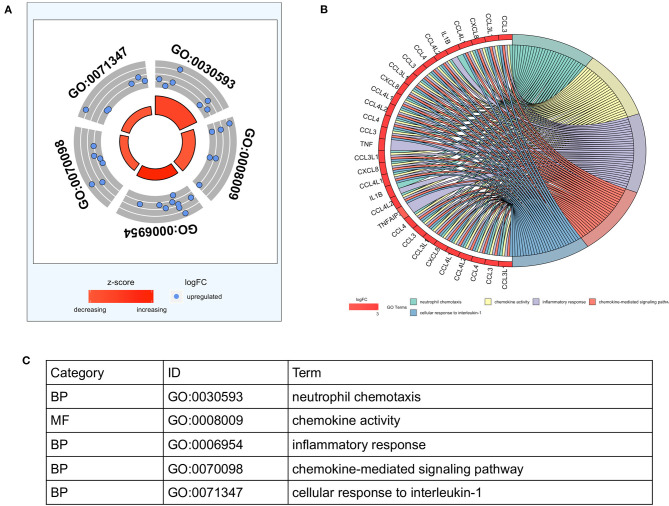
Functional enrichment analysis of 19 differentially expressed genes (DEGs) in pSS associated thrombocytopenia. (A) The outer circle represents the expression (log FC) of DEGs in each enriched GO (gene ontology) term: blue dots on each GO term indicate upregulated DEGs. The inner circle indicates the significance of GO terms (log10-adjusted P-values). (B) The circle indicates the correlation between the top 9 DEGs and their gene ontology terms. (C) The distribution of DEGs in significant GO terms. DEGs, differentially expressed genes; pSS, primary Sjögren's syndrome; FC, fold change; BP, biological process; MF, molecular function.